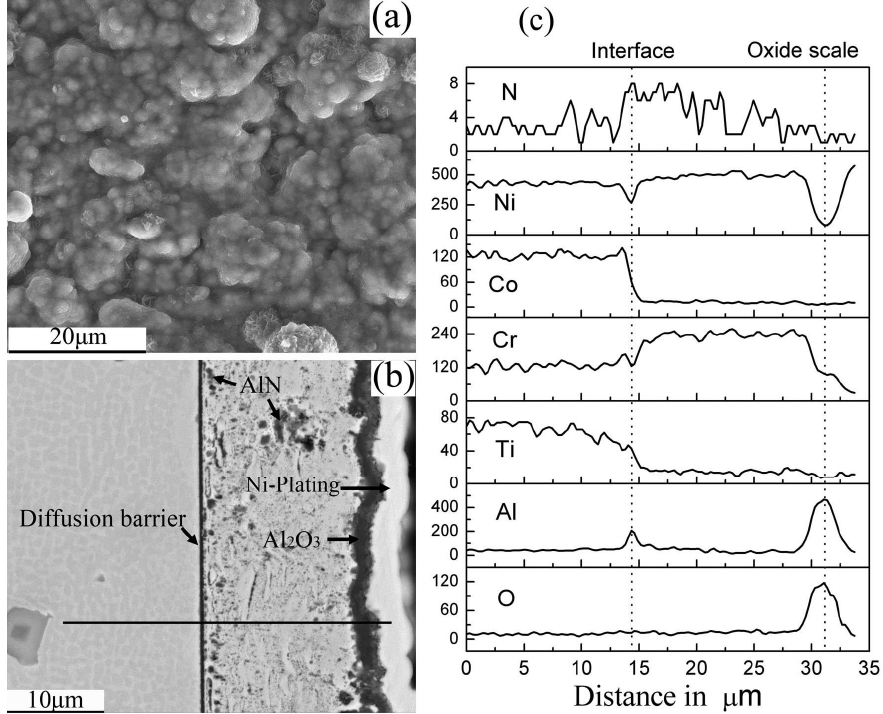
Figure 7. Surface SEM image ( a ), Cross-sectional BSE image ( b ) and the element depth profiles (( c ), analyzed by EDX) of K417/ AlN/Ni+CrAlYSiN coating system after oxidation for 100 h at 1000 °C in air.